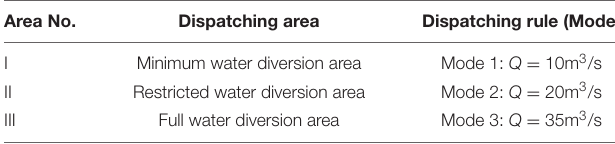
TABLE 1 | Dispatching areas and rules of the water diversion scheduling